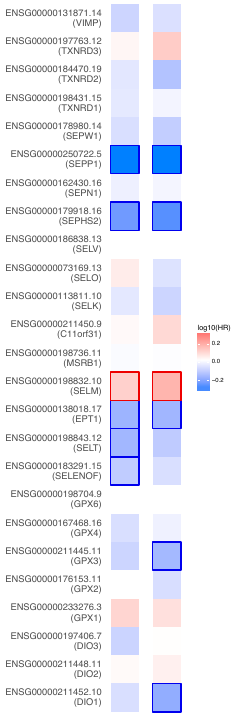
( HR ) illustrating KIRC-selenoproteins pairs with altered prognosis Figure A1. Heat map of log 10 (GEPIA2). We selected median as the suitable expression threshold for splitting the high-expression and low-expression cohorts. The hazards ratio (HR) was calculated based on Cox PH Model, and the HR value was scaled in decibel (dB). The red and blue color presented poor and good prognosis, respectively, and the intensity of color indicated the value of HR. The bounding box around the tiles represented whether there was statistical significance of the survival probability between the high and low expression groups in each cancer types ( p < 0.05). From the OS and DFS results, SEPP1, SEPN1, SEPHS2, SELM, EPT1, SELT, SELENOF, GPX3, and DIO1 were screened out for their prognostic value in renal clear cell carcinoma. Overall survival (OS), Disease-free survival